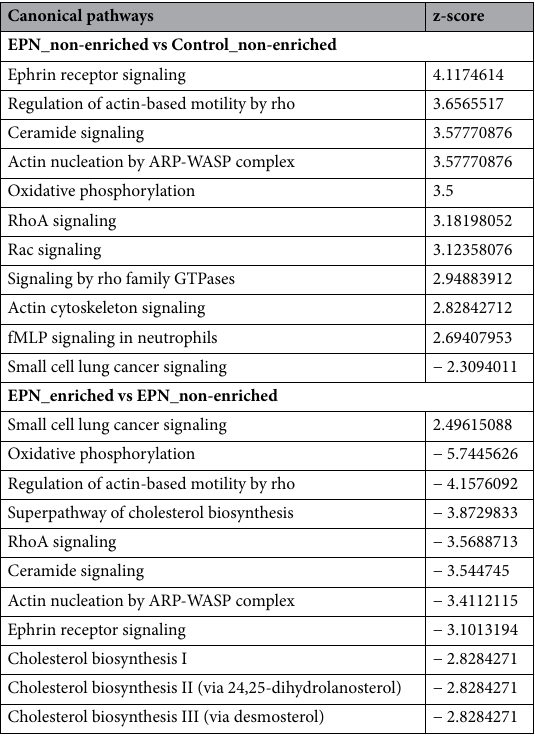
Table 1. Top canonical pathways from ingenuity pathway analysis (activation z-score ≥ 2 or ≤ − 2 and p-value < 0.05). Top 10 canonical pathways whose expression was modified by Pb exposure in animals from the non-enriched condition and in which enrichment reversed the direction of the gene expression change. EPN early postnatal Pb